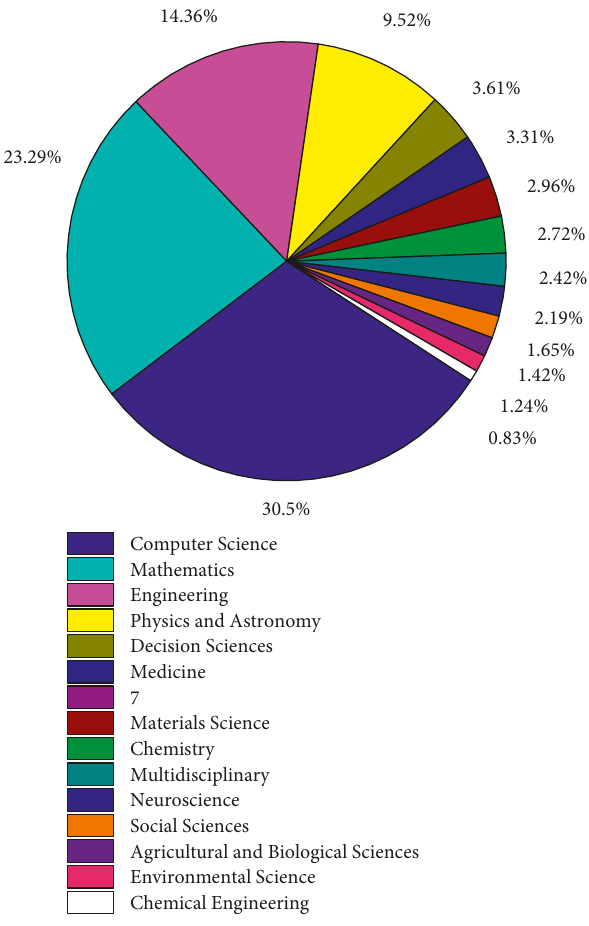
Figure 1: Bibliometric analysis of the publications of entropy in various